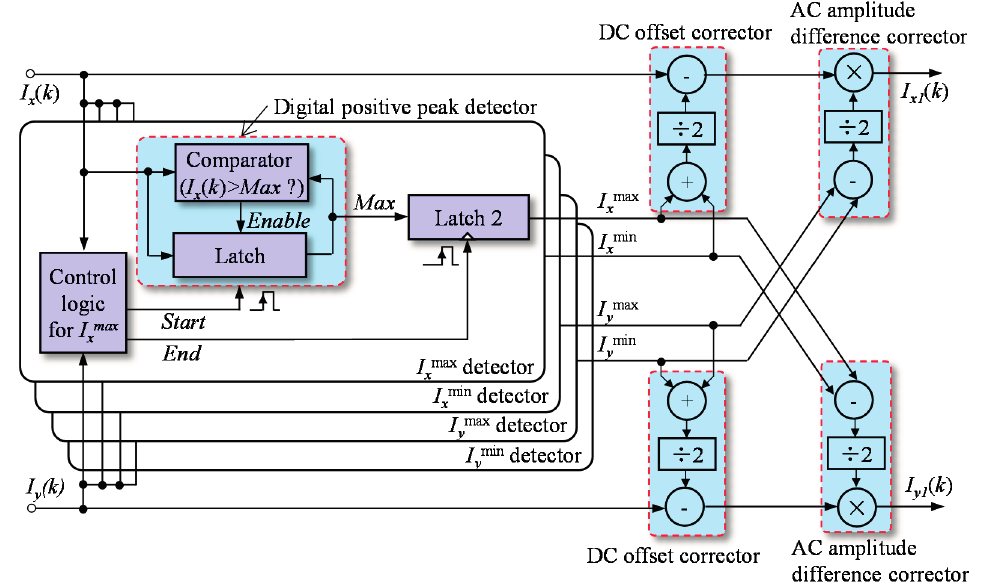
Figure 5. Correction of the DC offset correction and AC amplitude